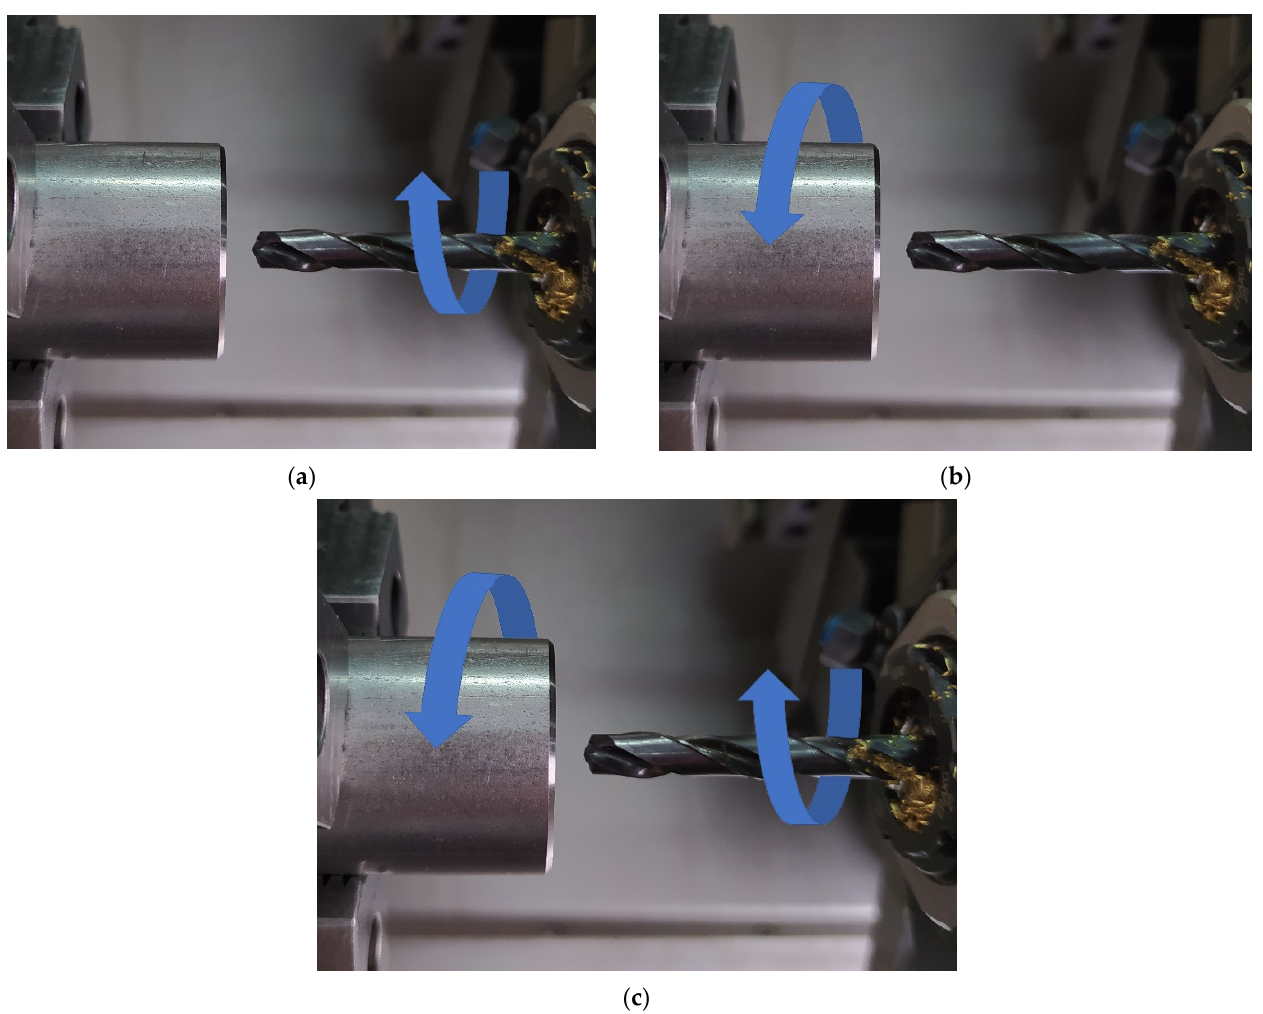
Figure 2. Kinematic systems: ( a ) the first kinematic system, ( b ) the second kinematic system; ( c ) the third kinematic system.